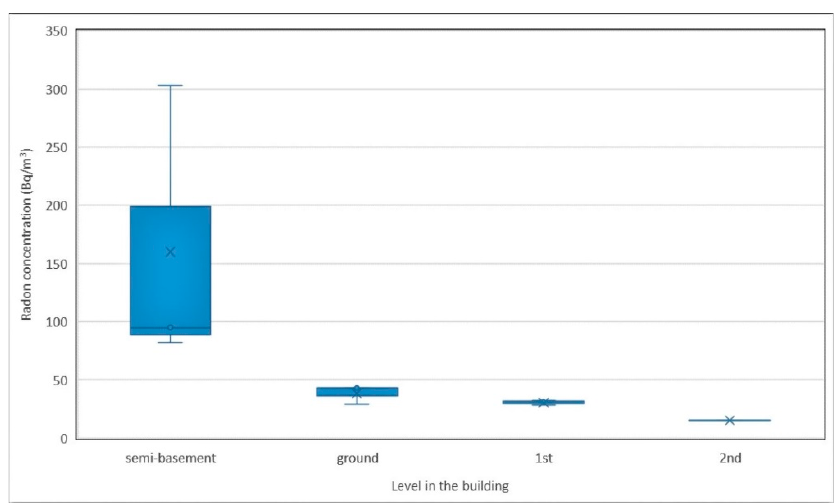
Figure 2. The distribution of annual indoor radon concentration according to floor level—school 2.